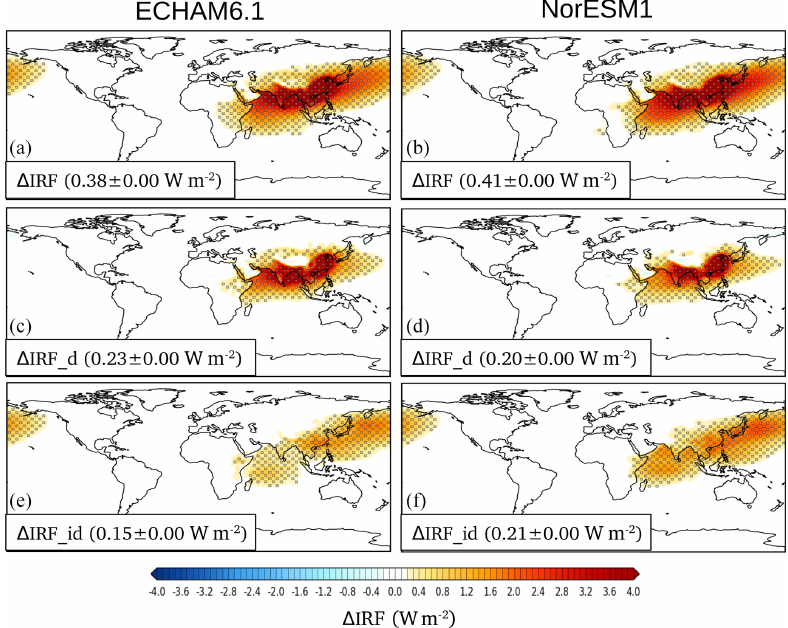
Figure A1. The change in the mean instantaneous radiative forcings for runs without and with SE Asian aerosols shown for the individual models ( a, c, e , ECHAM6.1; b, d, f , NorESM1).